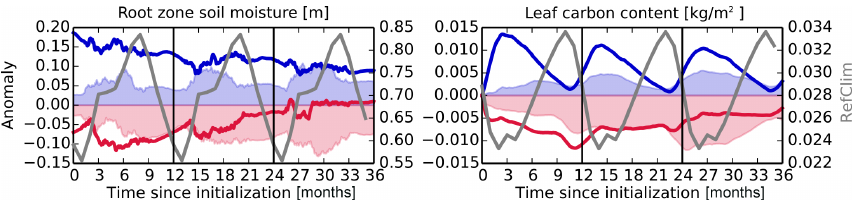
Figure 12. Ensemble mean anomaly (coloured lines) and standard deviation (shaded area) for root zone soil moisture (left) and carbon content in leaves (right) with the respective climatologies (grey) from the reference simulation. Blue colours indicate wet initialization and red colours indicate dry initialization. Time series are from a grid cell at − 2.8 ◦ N and 13.12 ◦ E.